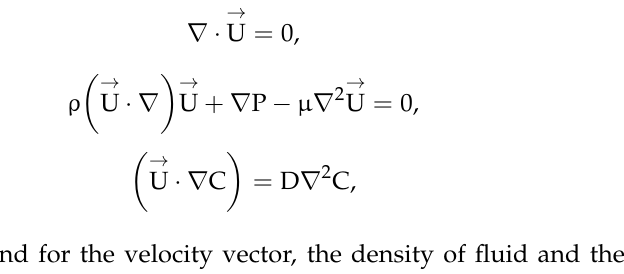
Table 1. Main physical parameters of the two fluids for mixing.